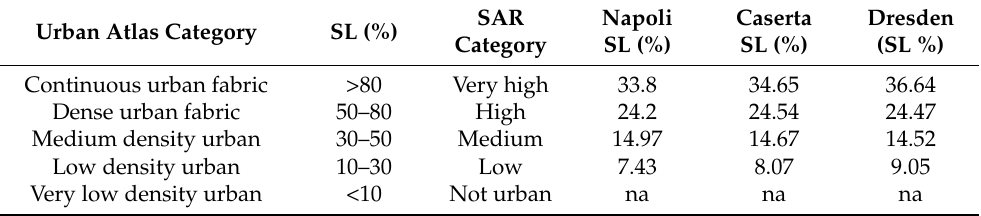
Table 5. Comparison between the Urban Atlas categories and the SAR categories reported in Table 1 in terms of SL. The SAR-derived SL percentage has been retrieved by calculating the mean density of pixels identified as urban used within the urban Atlas